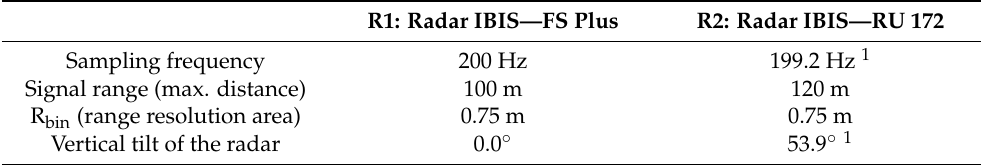
Table 4. Settings of used radars (bridge P ú chov). Figure 21. Three-dimensional model of the bridge with color-highlighted Rbins for radars R1 and R2, which were evaluated, and with marked positions of both radars below the structure BS2.